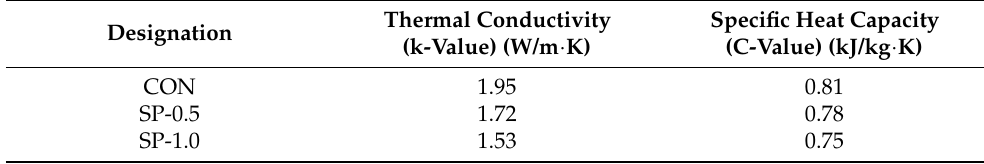
Table 4. Thermal properties of specimens.